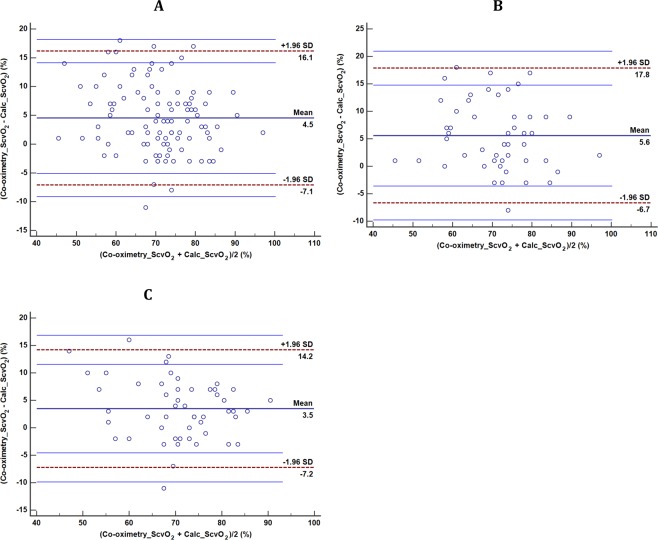
Bland and Altman plot of the difference against the mean of Co-oximetry ScvO2 and the calculated ScvO2.The solid line (dark bleu) represents the mean difference (bias) between both techniques. The dashed lines represent the upper and lower limits of agreement, whereas the solid lines (light blue) surrounding the upper and lower limits of agreement represent their 95% confidence intervals. (A) The whole population, (B) Septic shock patients, and (C) Non-septic shock patients.